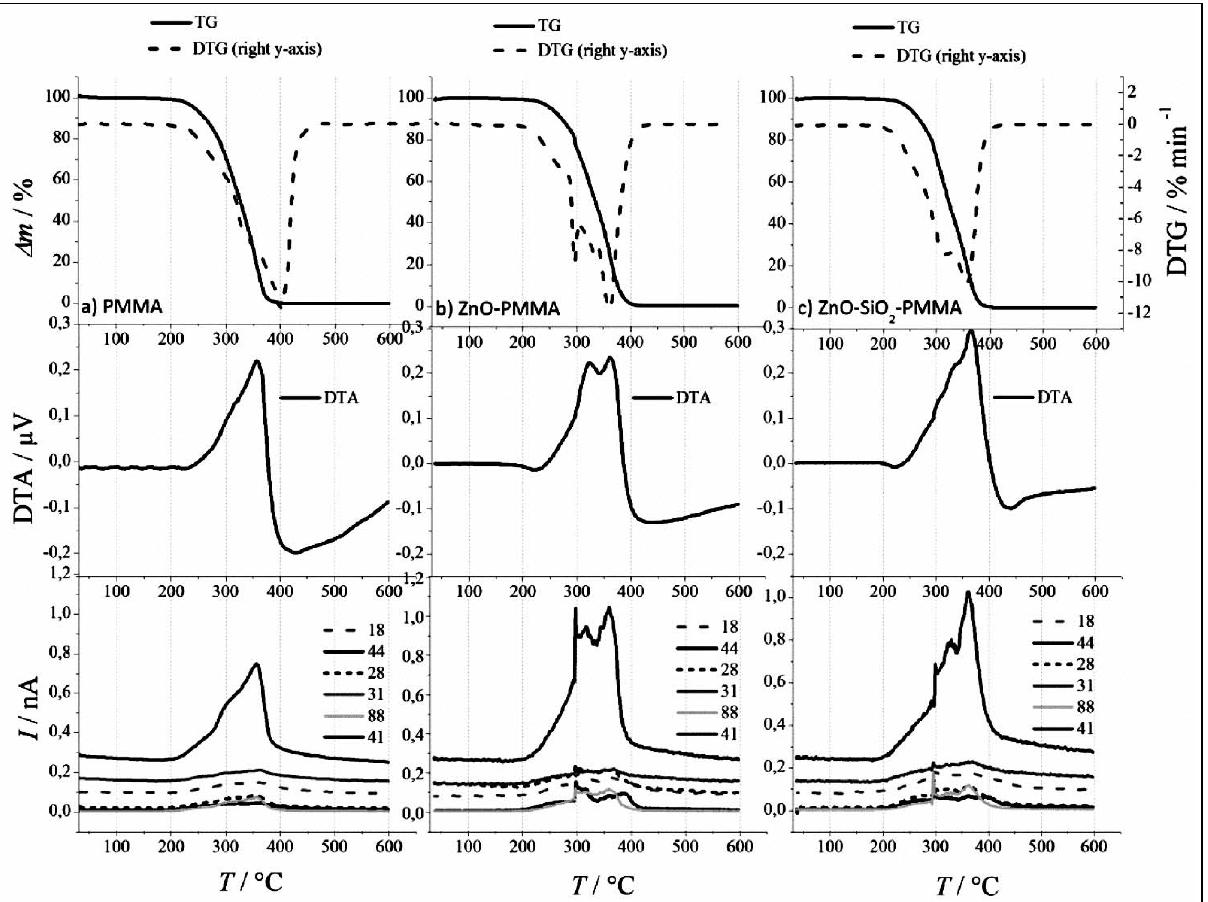
Figure 4. TG-DTG-DTA curves and QMS signals for thermal decomposition of samples A, B2 and